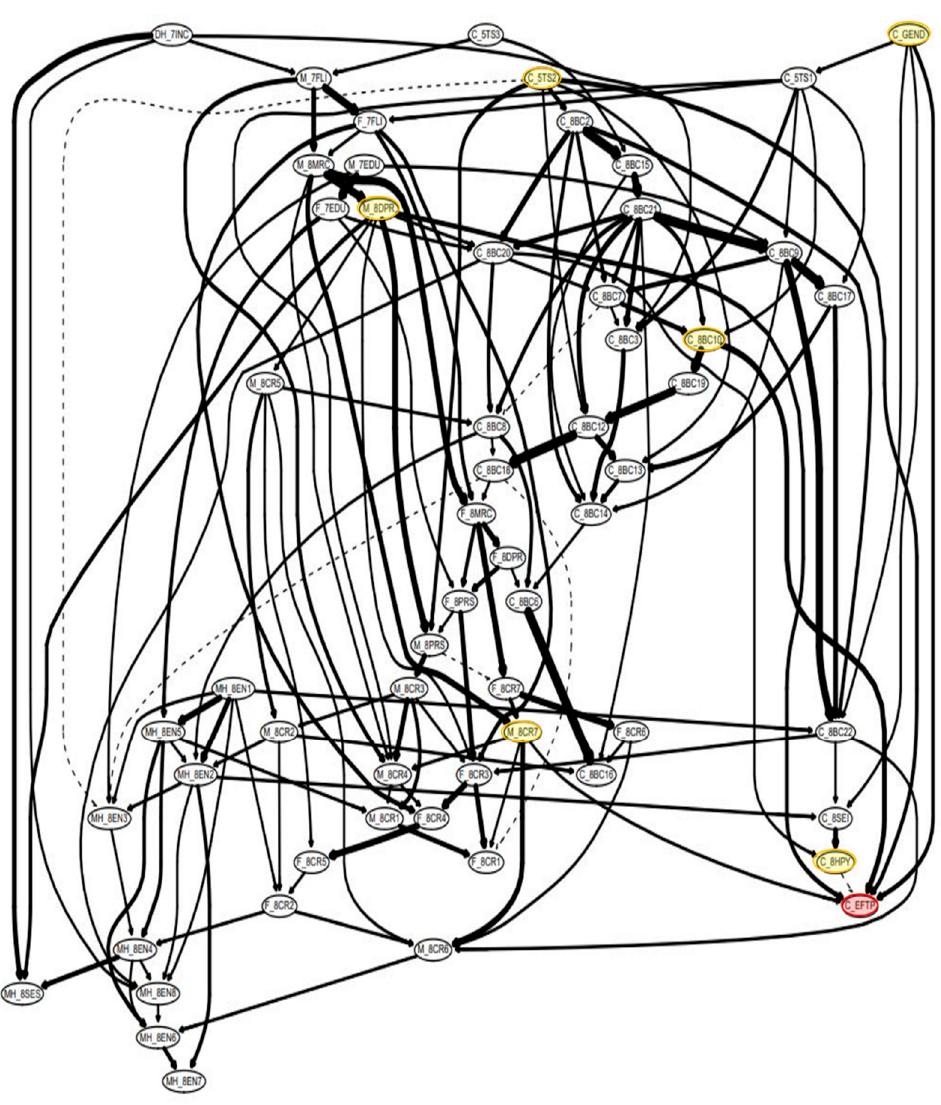
Figure 6. Class 1+2: Class 3 (threshold = .85). Bayesian network structure. Each node is a factor. The final effect node (red) in this study is a label indicating the type of EFD of each learning model (Bootstrapping = 2000). The red circles are the Effect nodes (C_EFPT) of model 4 (threshold = .85) and the yellow circles are the parent nodes (C_GEND, C_5TS2, C_8HPY, C_8BC10, M_8DPR, M_8CR7).